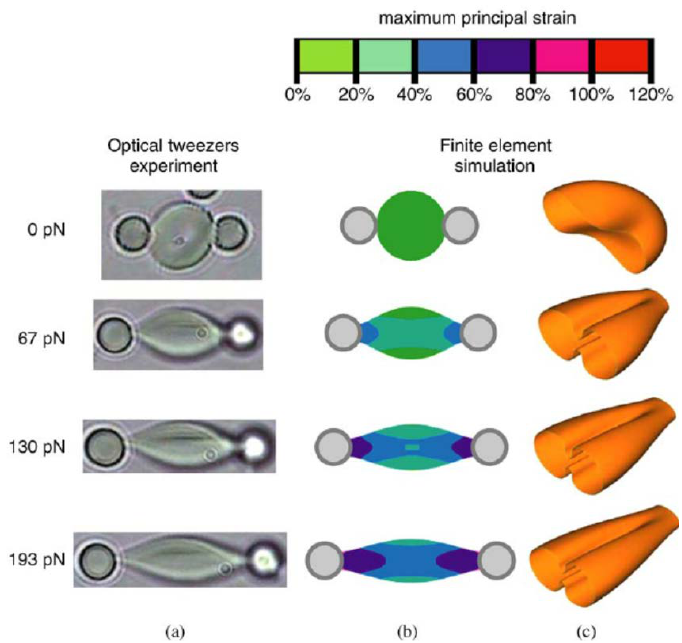
Figure 7. Snapshots of RBCs stretching using attached polystyrene beads; ( a ) experimental method to calibrate the relationship between the cell stretching force and the corresponding deformation of human red blood cells (RBCs); ( b , c ) mechanical model to establish the relationship between the force and deformation using finite element analysis.